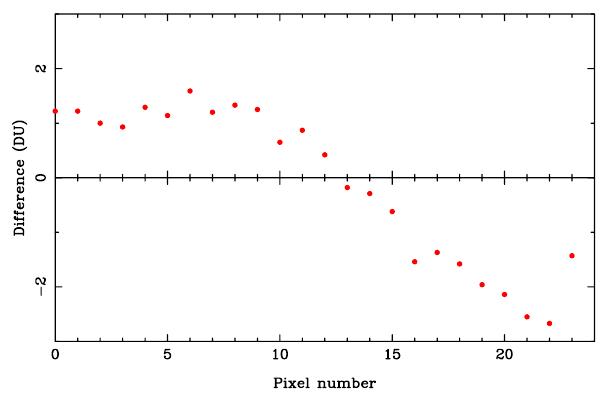
Fig. A2. The viewing angle correction for